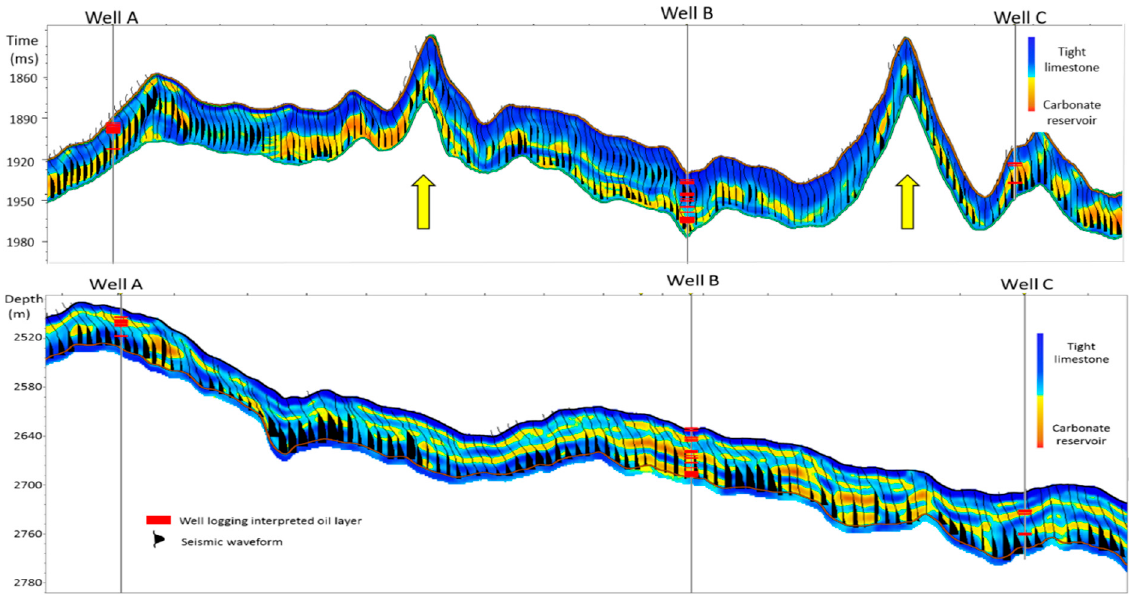
Figure 9. Time-domain inversion result ( upper ) and depth-domain inversion result ( lower ) of Г 1–2 , KT-II. See Figure 10 for the location of the profile.